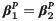
Normalized point estimates of APC coefficients for U.S. white men’s heart disease mortality rates, ages 35+ between years 1973–2010, estimated from APC models using CGLIM with a β1P=β2P constraint, IE constraint, MEE constraint, HAPC-CCREM-MCMC constraint, and BAM constraint.